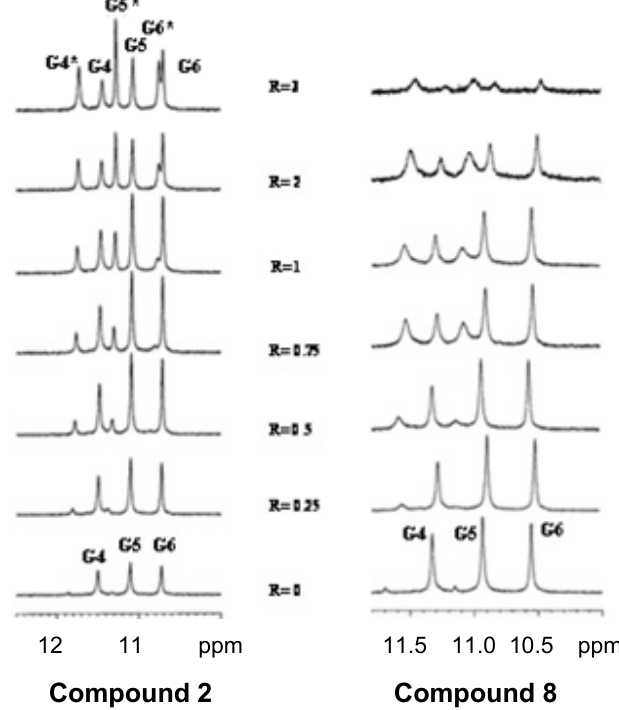
Figure 4. Imino proton region of (TTAGGG) quadruplex with compounds 2 and 8